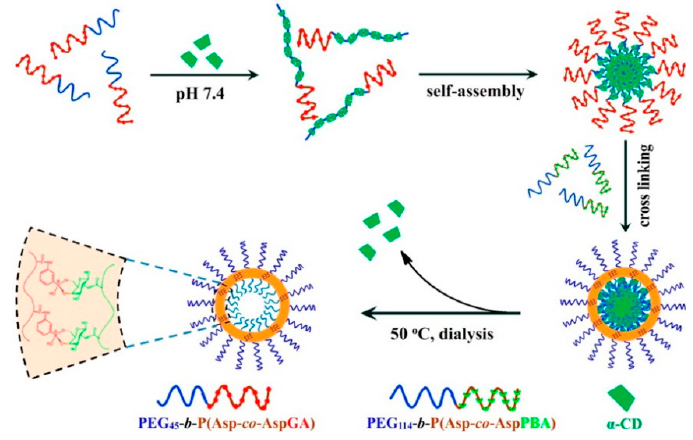
Figure 6. Schematic representation of the fabricated polymer vesicles using a α CD/PEG inclusion complex-template strategy [49]. Copyright 2015 American Chemical Society. complex-template strategy [49]. Copyright 2015 American Chemical